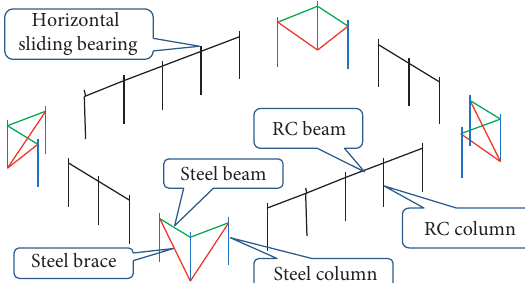
Figure 5: Steel and RC substructures.